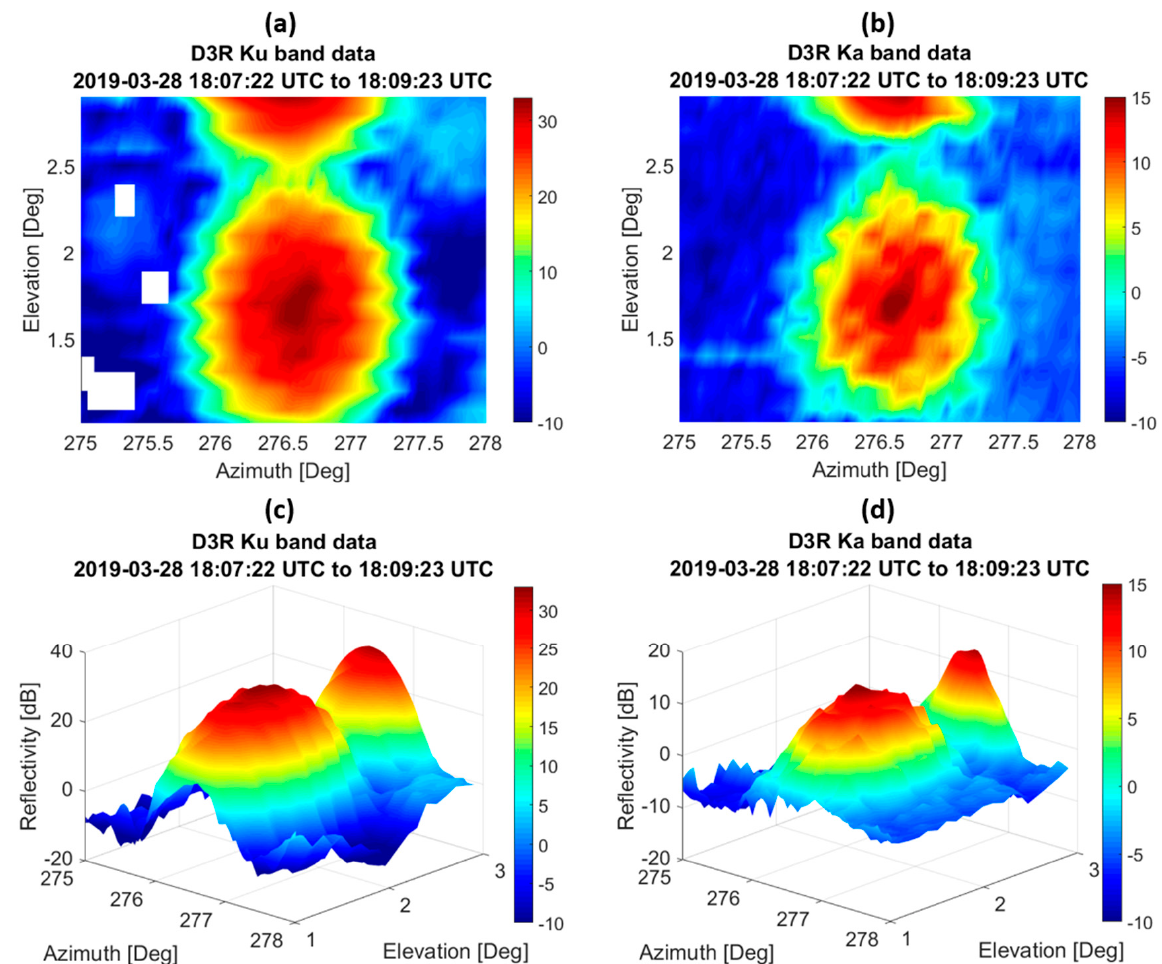
Figure 5. Raster scan data from D3R Ku and Ka radar for the calibration experiment. ( a ) Ku data; ( b ) Ka data; ( c ) 3-D view of Ku data; and ( d ) 3-D view of Ka data.